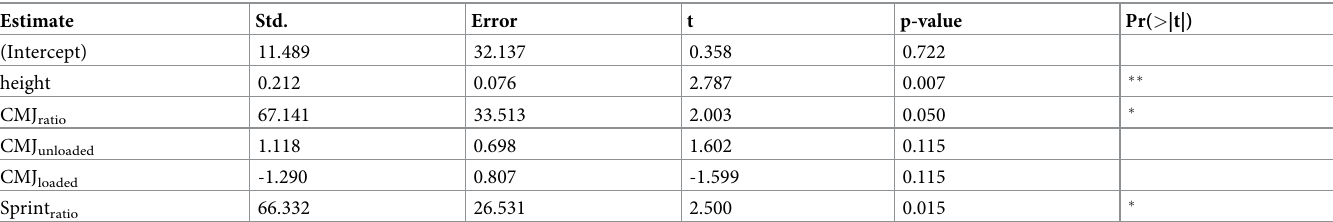
Table 2. Coefficients with p values for parameters.